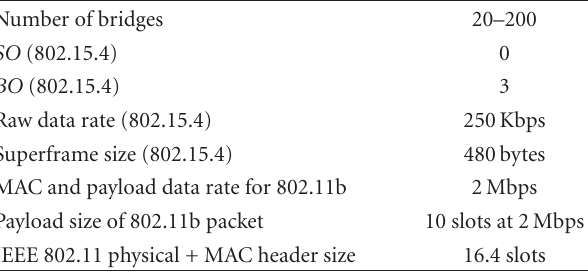
Table 3: Parameters used in the analytical